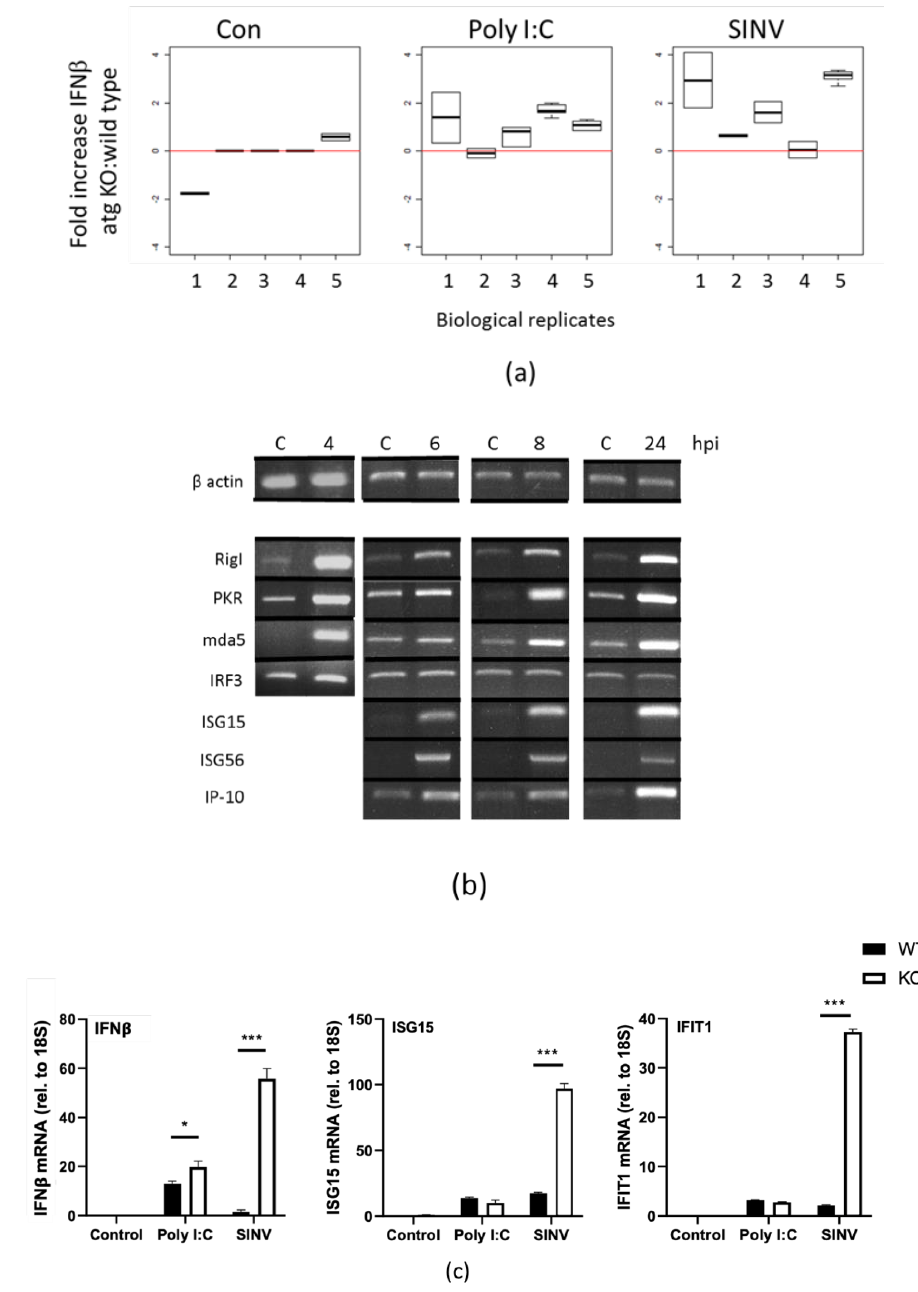
Figure 6. ATG16L1 attenuates interferon β mRNA and protein secretion, and ISG gene expression in SINV infected cells.( a ) Interferon β secretion from control cells cells (CON), cells treated with synthetic dsRNA (Poly I:C), or cells infected with SINV. Fold increase in interferon secretion from ATG16L1- / - cells relative to wild type cells is shown for control cells, cells transfected with poly I:C with lipofectamine and cells infected with SINV for 24 hpi. Graph shows values for 5 independent biological replicates. ( b ) MEF cells were infected with SINV for 4, 6, 8 and 24 hpi with matching controls isolated at the same time point. mRNA for ISGs RIG-I, PKR, MDA5, ISG15, ISG56 and IP-10 are shown by semi-quanitative RT-PCR. Beta actin shows equal lane loading and IRF3 is a non-responsive gene. ( c ) qPCR using primers for IFN β , ISG15 and IFIT1 (ISG56) using total RNA from MEFs (WT) and MEFs deleted in ATG16 (ATG16L1- / -) either transfected with dsRNA (Poly I:C) or infected with SINV for 4 h. WT cells (black bars) and ATG16L1 - / - cells (white bars). ∆∆ Ct relative to 18S. (*) p -values < 0.05; (***) p -value <